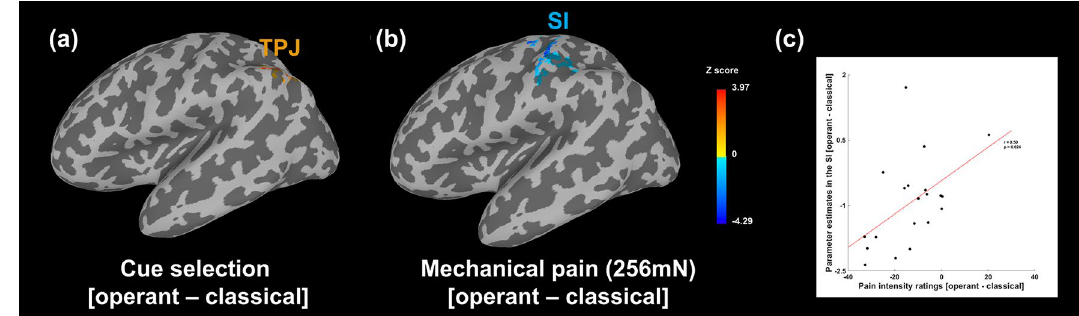
Figure 3. Brain responses during cue selection ( a ) and painful stimulation ( b ) (operant vs. classical learning). ( a ) Voxels in the left inferior parietal gyrus and superior temporal sulcus showed significantly greater activity during the voluntary choice of cues based on the anticipation of pain relief formed through instrumental learning compared to a simple motor task in classical conditioning (clicking the cue selected by the computer; peak coordinate: X = −45.5, Y = −60, Z = 56.5, 38 voxels, cluster-level FWE corrected p < 0.05). ( b ) Perception of pain following the instrumental learning cues, compared with identical painful stimulation following the classical conditioning cues, was associated with decreased activity in the left primary somatosensory cortex, primary motor cortex, and parietal lobe (peak coordinate: X = −52.5, Y = −18, Z = 60, 94 voxels, cluster-level FWE corrected p < 0.05). ( c ) Pearson’s correlation analysis was performed to analyze the correlation between the parameter estimates of the left SI and subjective pain ratings. We found significant correlation between the reduced left SI activities and decreased pain ratings ( r = 0.50, p = 0.024). SI, primary somatosensory cortex; TPJ, temporoparietal